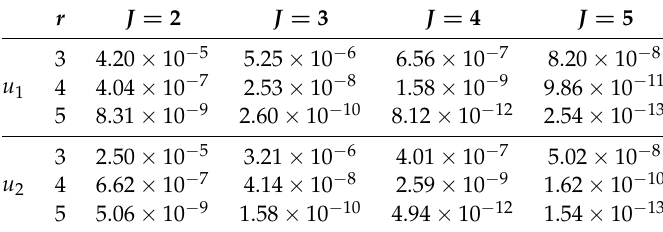
Table 2. Effect of the refinement level J and multiplicity parameter r on L 2 -error for Example 3.